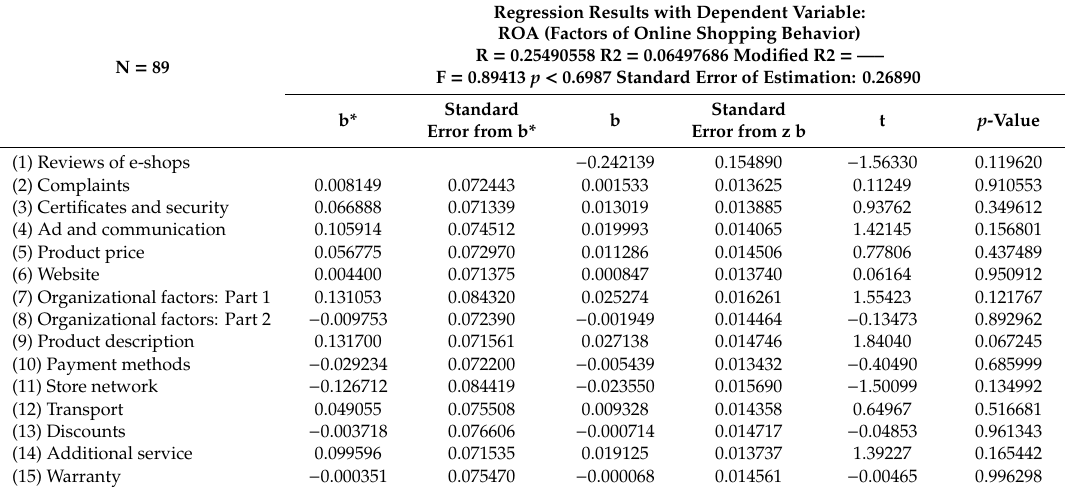
Table A2. Multiple regression between ROA and factors of online shopping behavior. Source: own processing (in the Statistica software).